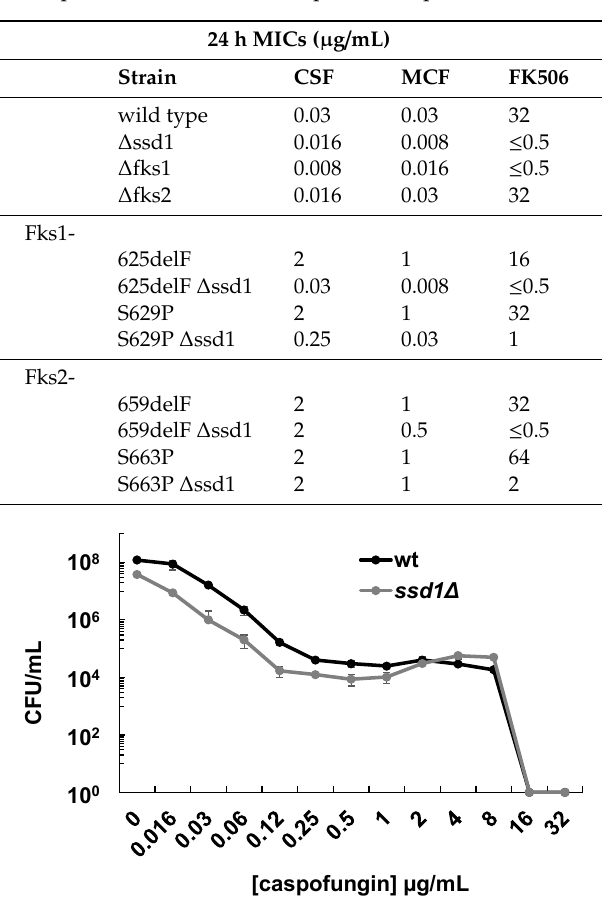
Figure 1. Disruption of predicted post-transcriptional regulator SSD1 produces minor increases in echinocandin killing. In vitro caspofungin killing assay of wild type and SSD1 knockout strains. Mean plus / minus SD of 2 independent experiments (each with 2 replicates) is shown. CFU, colony forming units. Table 2. Restoration of echinocandin resistance in fks1 ∆ ssd1 mutants upon heterologous expression of SSD1 . The SSD1 coding region was cloned onto pCN-PDC1 via gap-repair (pSSD1). Results are representative of three independent experiments. CSF, caspofungin; MCF,